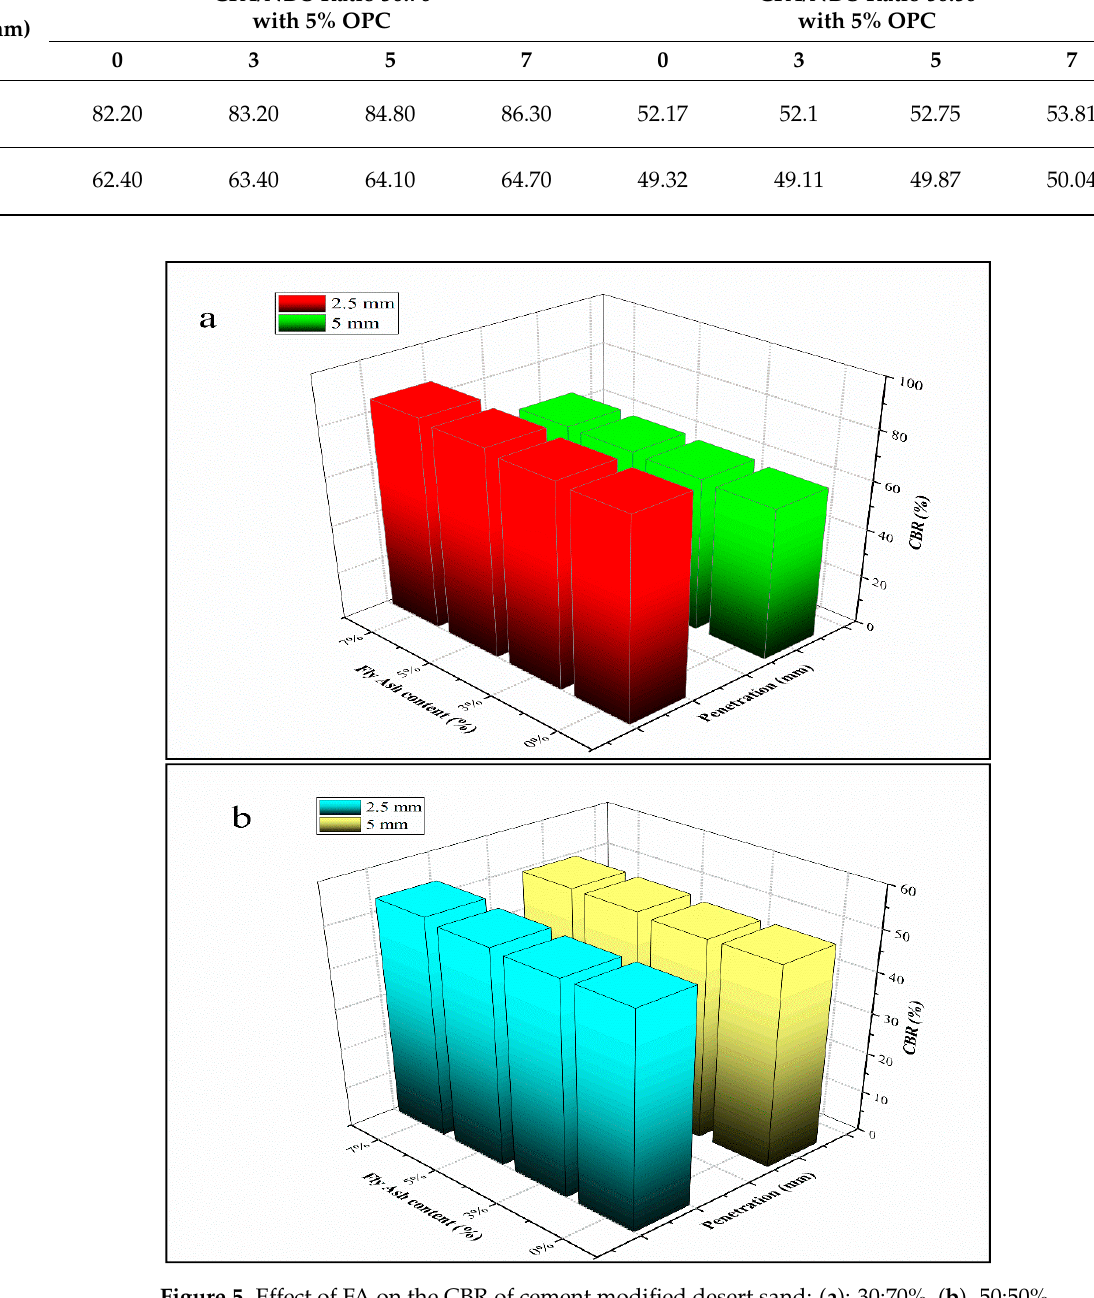
Figure 5. Effect of FA on the CBR of cement modified desert sand: ( a ): 30:70%, ( b ). 50:50%.